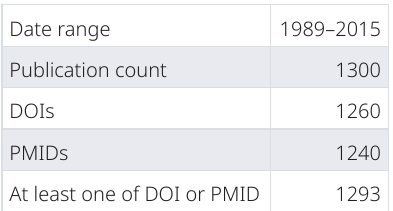
Table 2. Source metadata coverage.